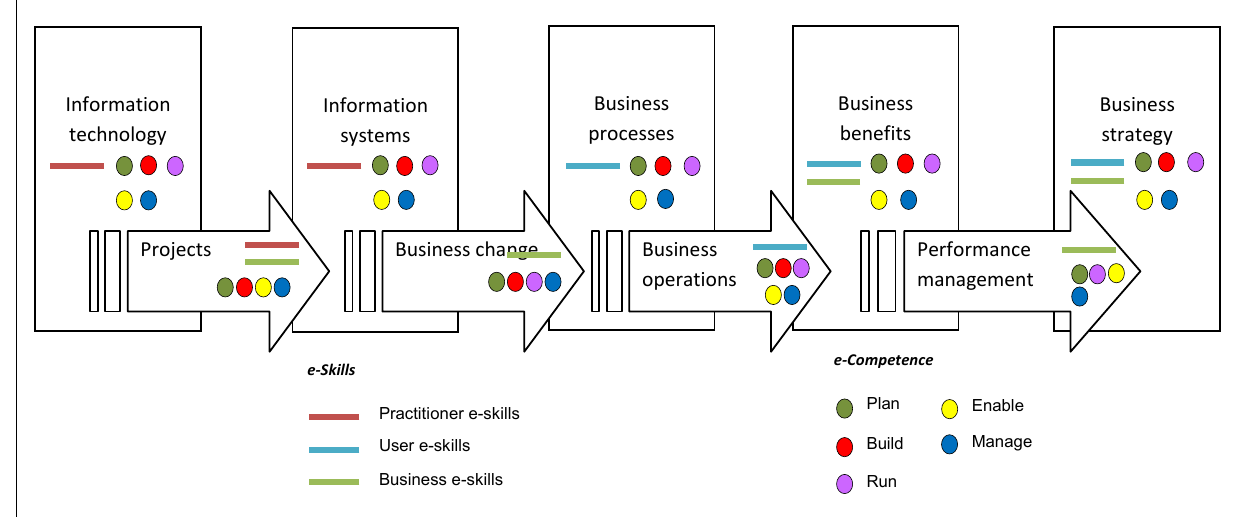
FIGURE 2 Mapping e-skills and e-competences against IMBOK areas and